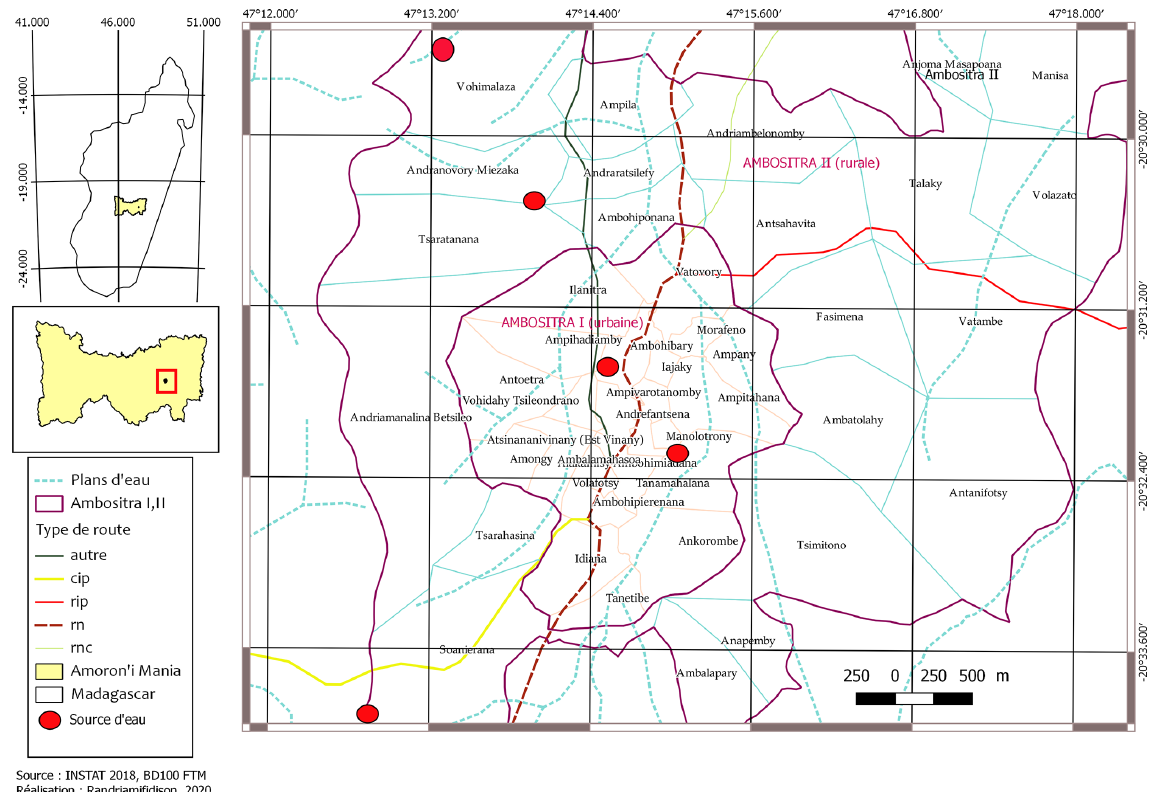
Figure 1. Carte de localisation de la zone d’étude (Réalisation : R. F. A – Rindramampionona Fanambinantsoa Ankasitrahana).